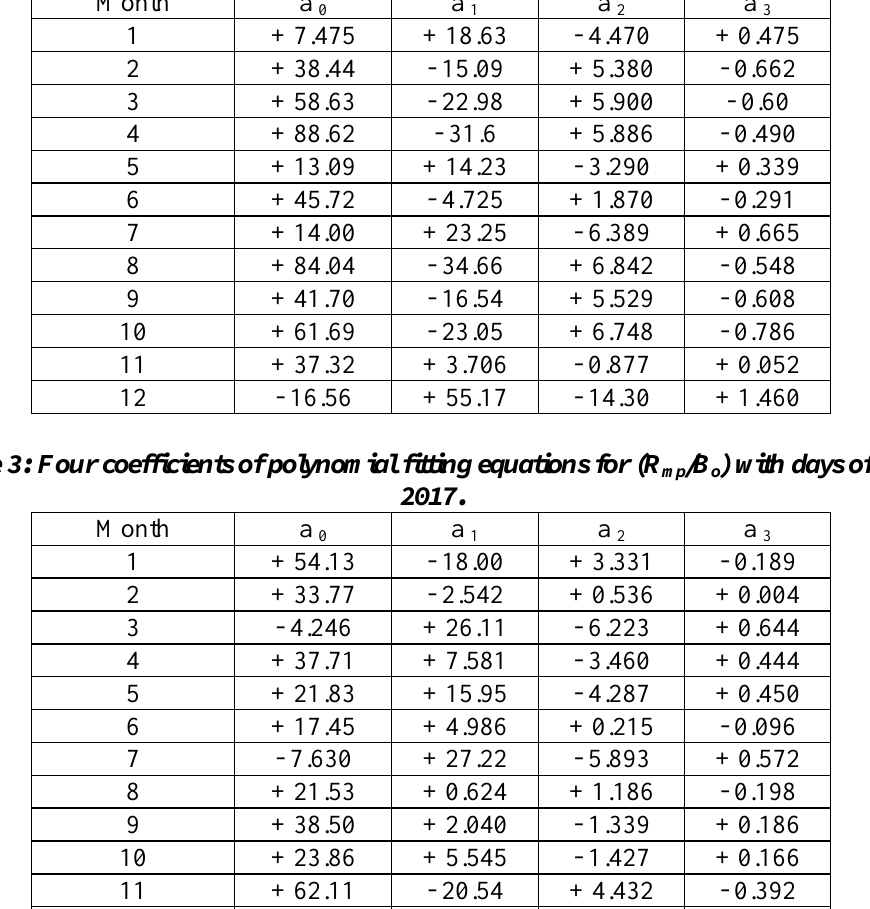
/B ) with days of year mp o